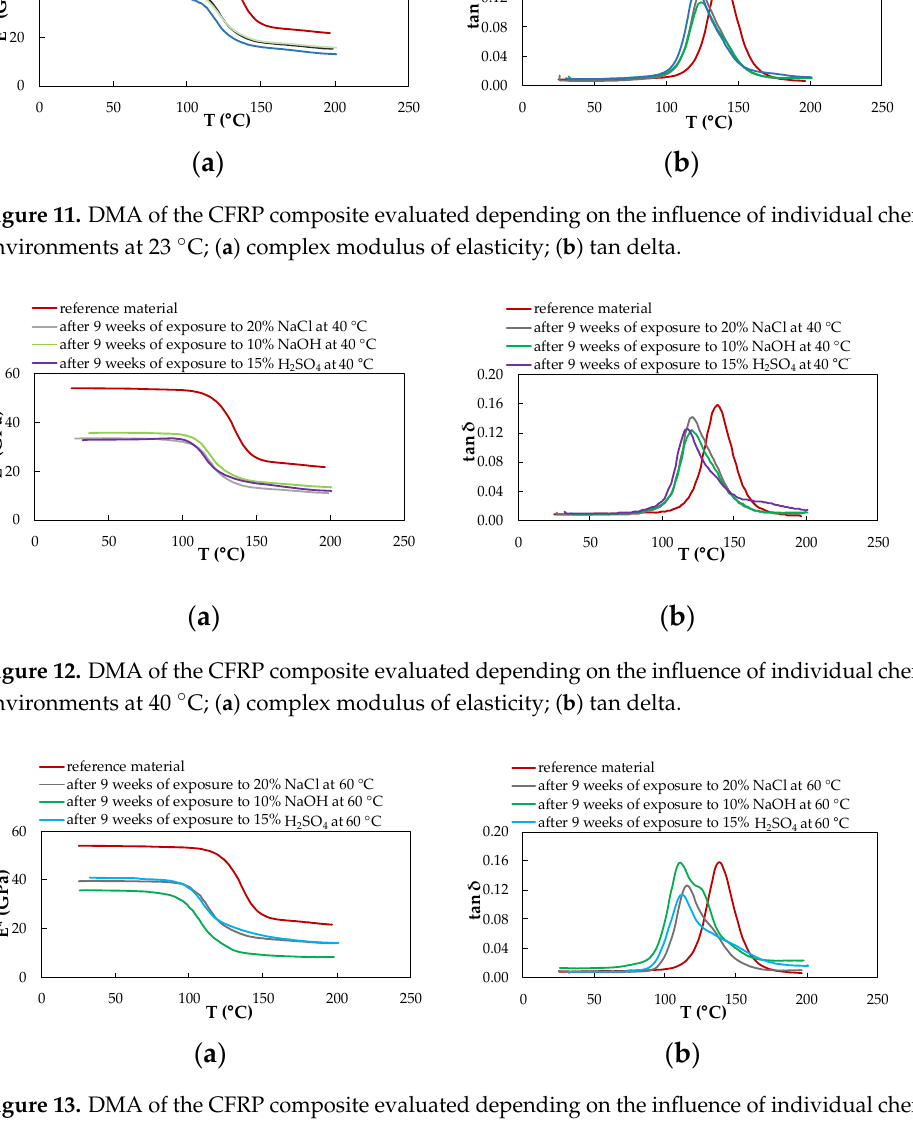
reference material after 9 weeks of exposure to 20% NaCl at 23 °C after 9 weeks of exposure to 10% NaOH at 23 °C after 9 weeks of exposure to 15% H2SO4 at 23 °CH 2 SO 4 at 23 ° C